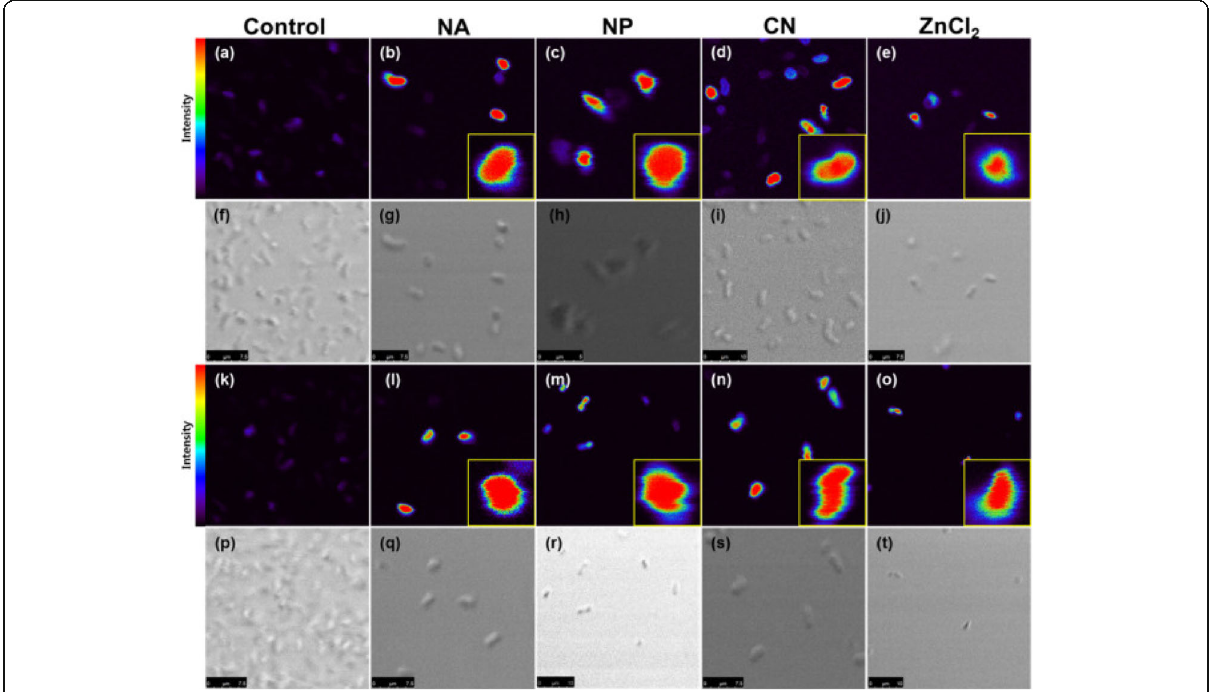
Fig. 3 Two-photon fluorescence microscopy and bright-field images of AZn2-labeled ( a – j ) S. aureus and ( k – f ) K. pneumoniae . Both species were treated with ZnO NPs (NA, NP, and CN) and ZnCl 2 of 0.35 mM. Two-photon images were collected at 500 – 620 nm upon 780 nm excitation with femtosecond pulses. Reproduced from ref. [16] with permission from